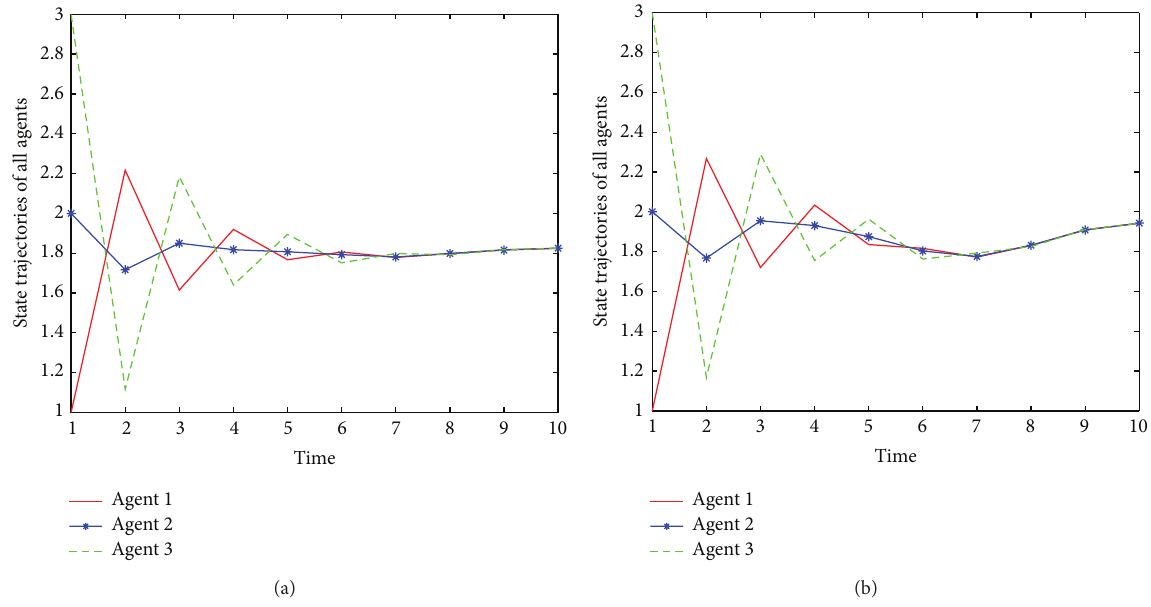
Figure 3: (a) State trajectories of all agents when 𝛾 = 0 . 02. (b) State trajectories of all agents when 𝛾 = 0 . 08.